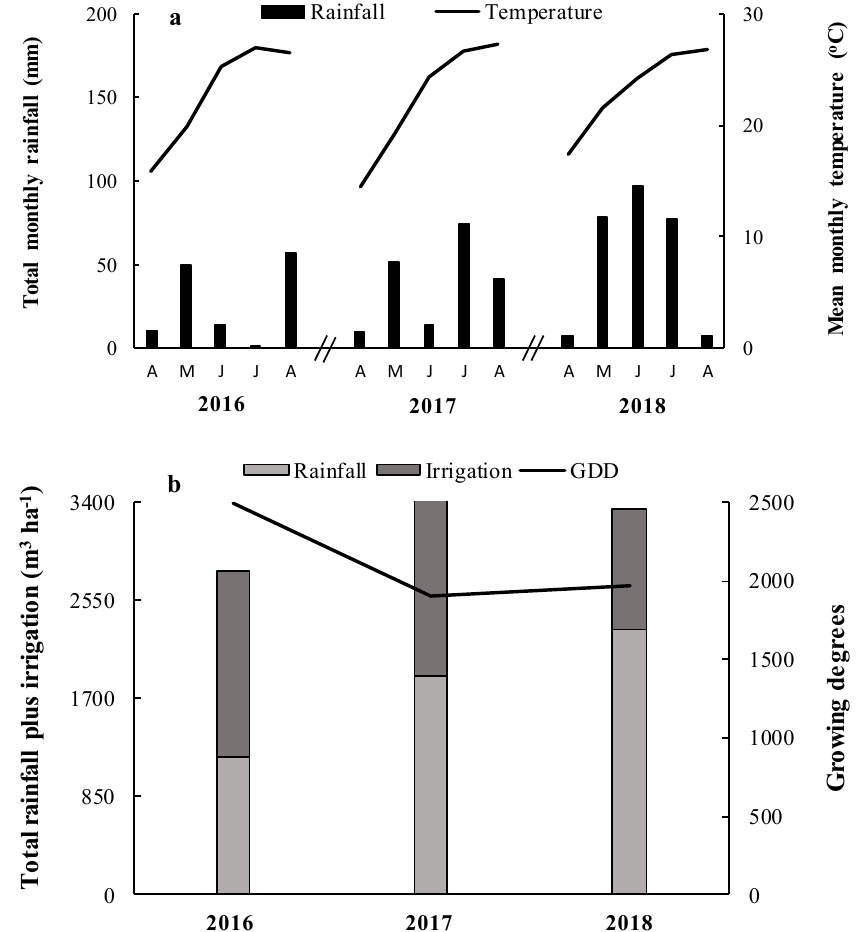
Figure 1. Total monthly rainfall and mean monthly temperature ( a ) and total water inputs and Growth Degree Days ( b ) during the three hemp growing seasons.